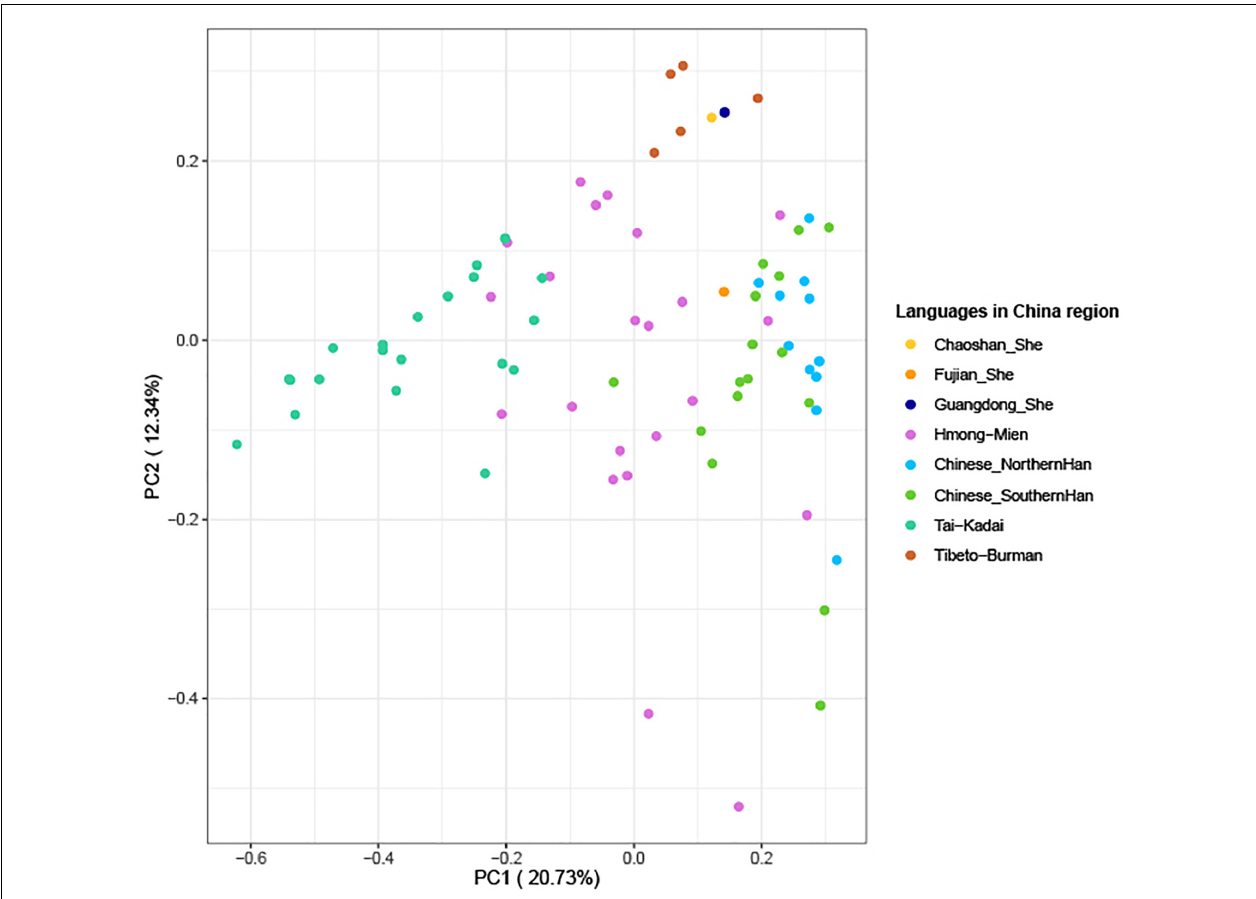
FIGURE 7 | Principal component analysis based on Y-haplogroup frequencies between three She groups and 74 populations (4,195 individuals in total, which included 22 Hmong-Mien, 20 Tai-Kadai, 16 Southern Han, 11 Northern Han, and five Tibeto-Burman language-speaking populations mainly from Southeast and East